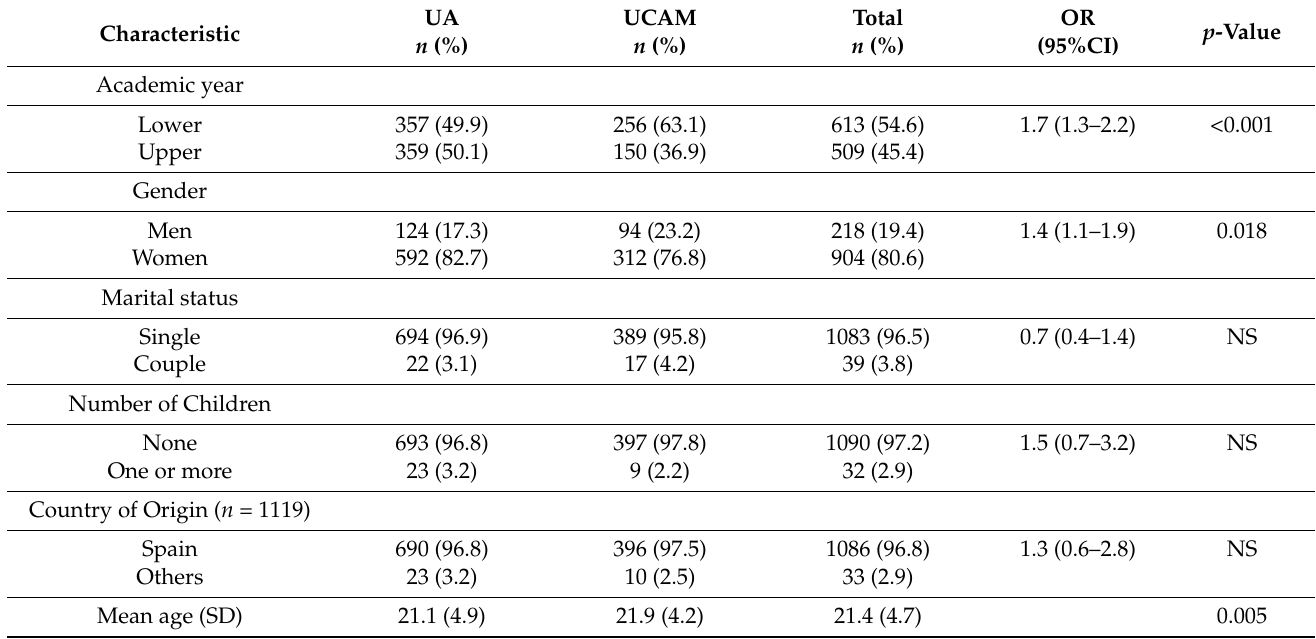
Table 2. Sample characteristics ( n = 1498).